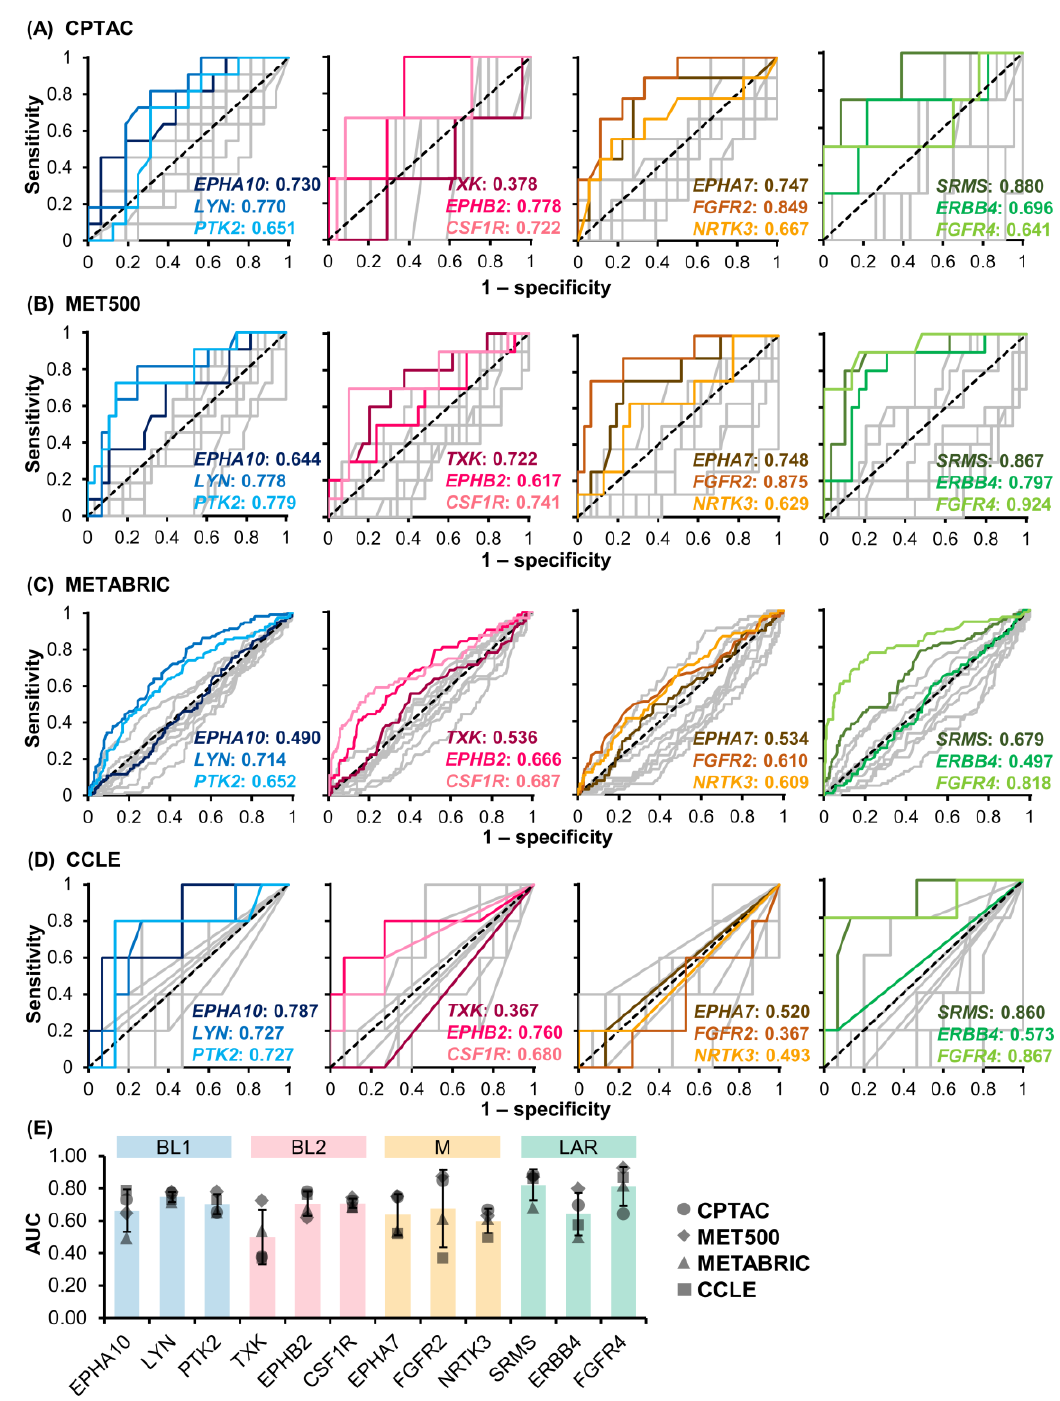
Figure 6. ROC analysis of signature TK genes in four datasets, including ( A ) CPTAC, ( B ) MET500, ( C ) METABRIC, and ( D ) CCLE. The blue, pink, orange, and green displayed the candidate signature TK genes in the BL1, BL2, M, and LAR subtypes, respectively, while grey lines illustrated the remaining TK genes. The area under the ROC curve (AUC) of each TK gene was shown in the lower right corner (TK gene:AUC). ( E ) The average AUC across the four datasets was summarized (mean ± standard deviation) with color and symbol according to the subtypes and datasets.